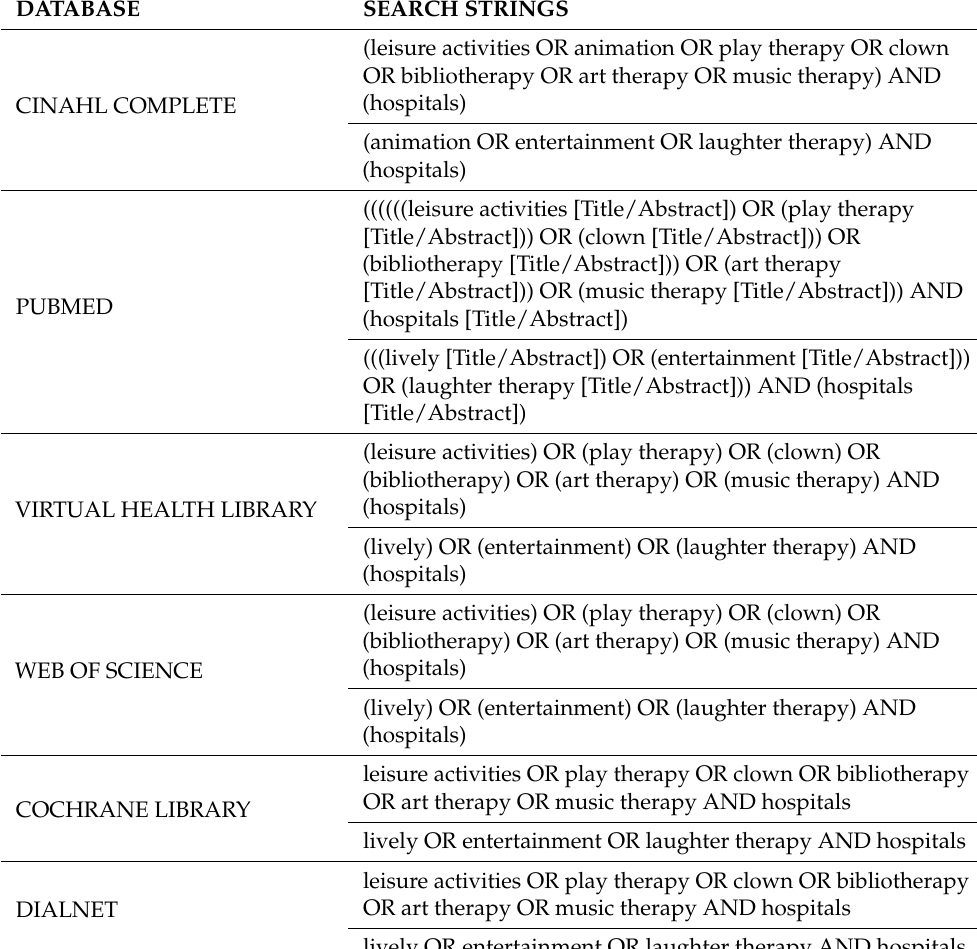
Table A1. Search strings for each